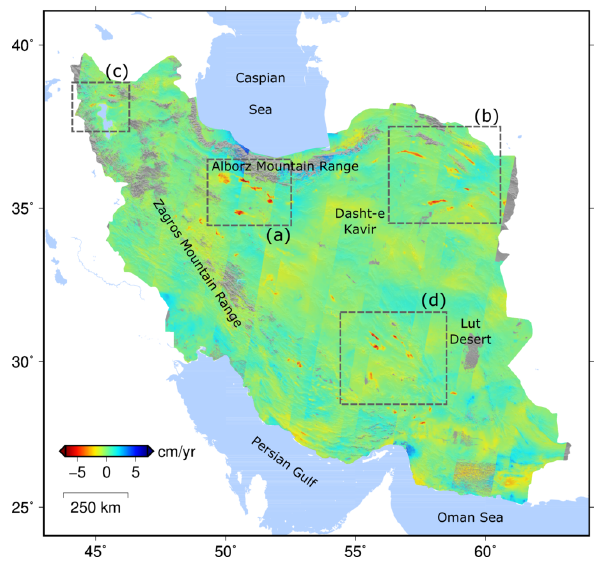
Figure 3. The linear rate of displacement across Iran obtained from Sentinel-1 time series analysis at a medium resolution of 100 m. The color scale is saturated between ± 7 to highlight small subsidence areas. Four subsidence hot spots indicated by dashed lines are shown in details in figure 4.